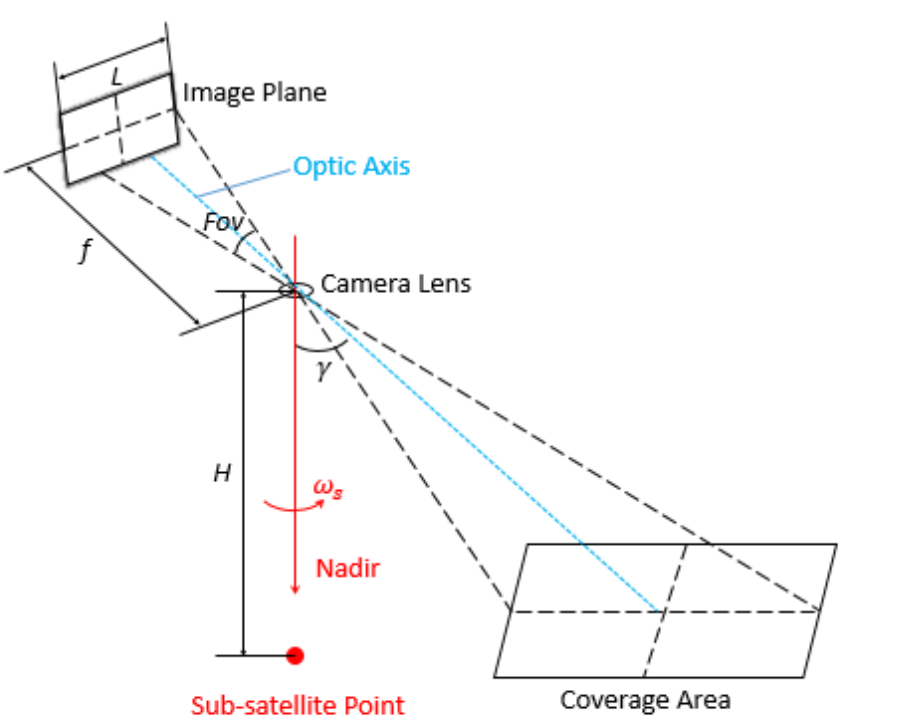
Figure 5. Mapping of the image plane to the Earth.